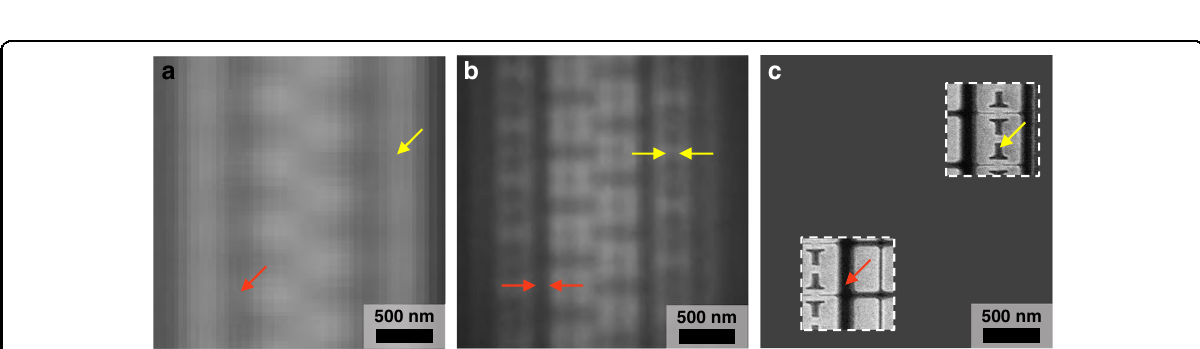
Fig. 8 Comparison of intensity and normalized intensity for ×50 SR, ×100SR, and ×530 MASR. a Intensities in the wavelength range of 430 – 700 nm for ×50 SR, ×100 SR, and ×530 MASR. b Intensities and normalized intensities for ×50 SR, ×100 SR, and ×530 MASR.